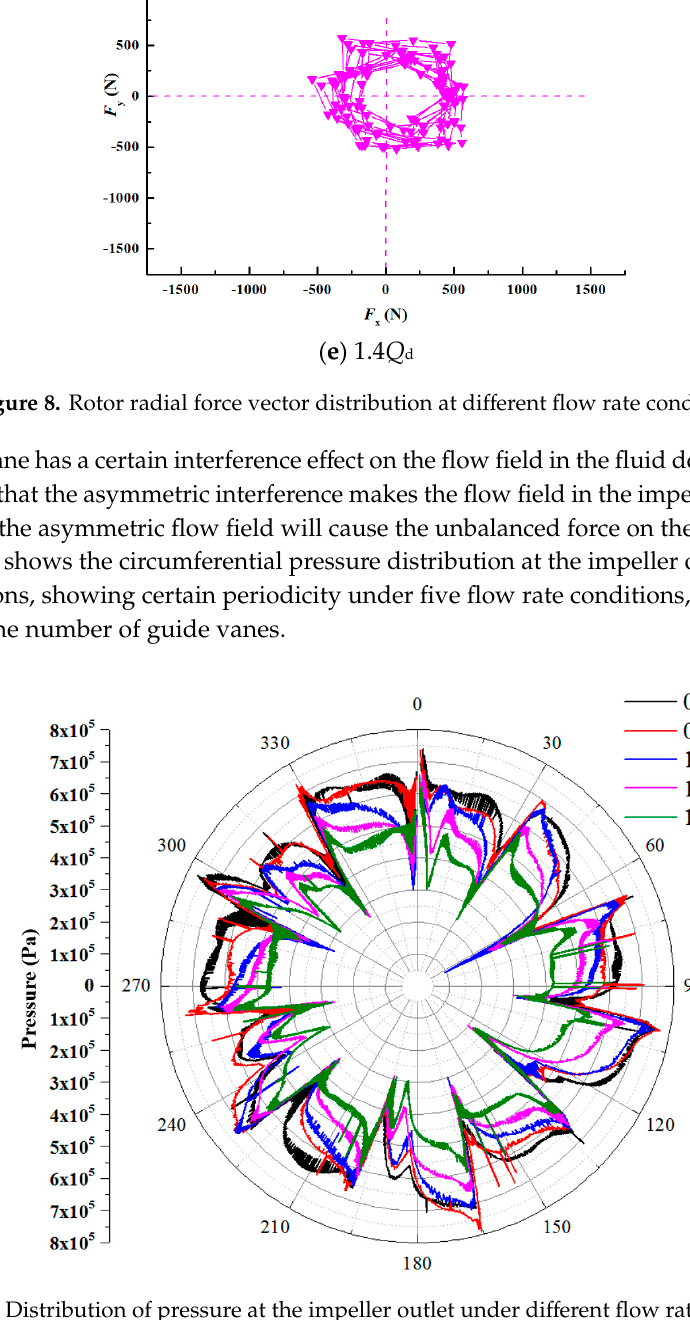
Figure 9. Distribution of pressure at the impeller outlet under different flow rate conditions.